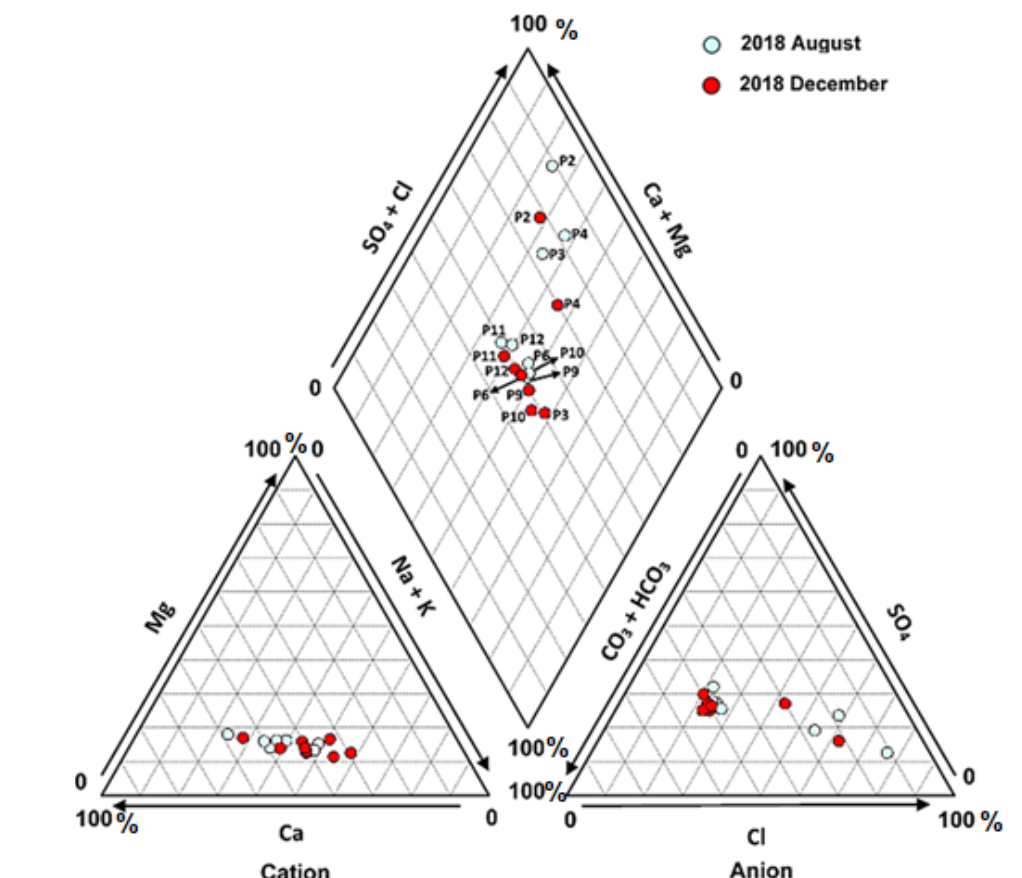
Figure 3. Piper diagram showing the hydrochemical characteristics of the Manglaralto aquifer groundwater samples of the campaigns in August 2018 and December 2018.